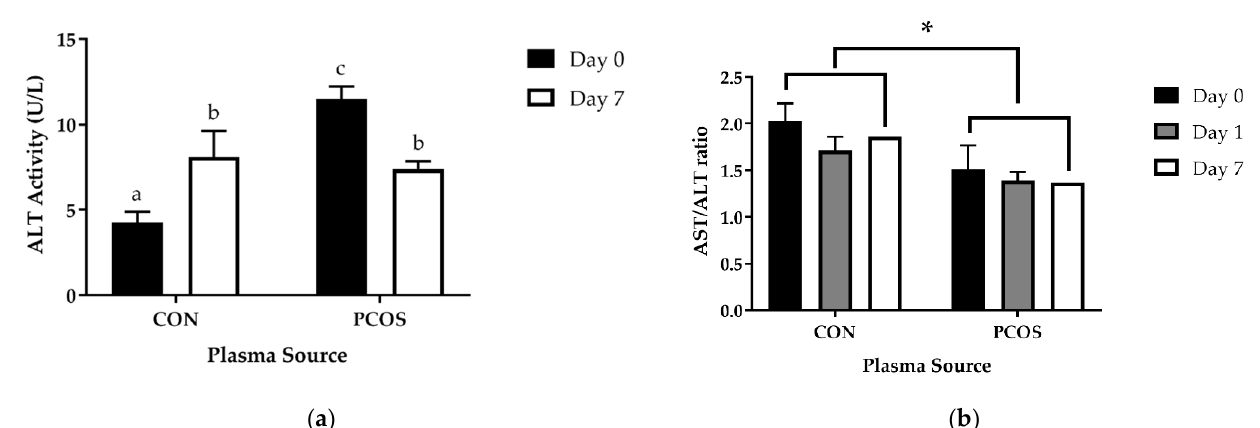
Figure 10. Mean (±SE) ( a ) ALTact and ( b ) AST:ALT levels in CON and PCOS across days different letters equate to statistically significant differences ( p < 0.05). * = significance between groups, p < 0.05. CON = non-PCOS women; OGTT = oral glycemic tolerance test; PCOS = women with polycystic ovarian syndrome.